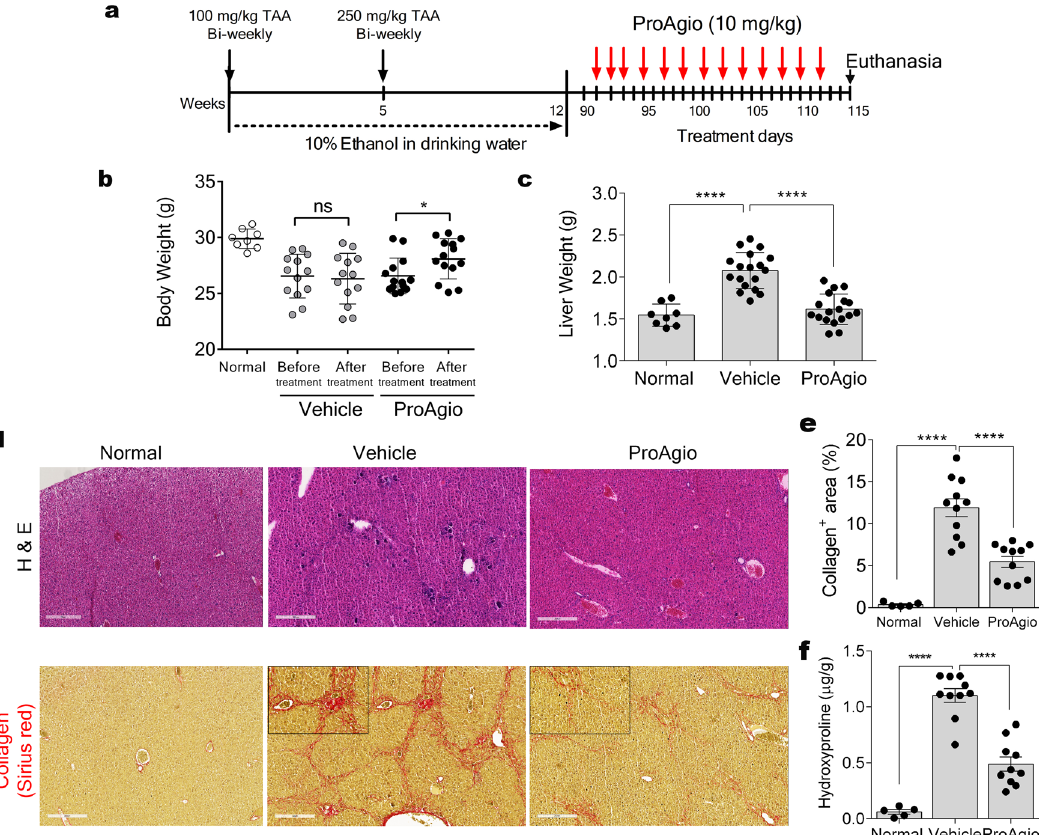
Fig. 2 ProAgio reverses liver fi brosis. a Schematic illustration of the schedule of TAA/alcohol liver fi brosis induction and subsequent ProAgio treatments (red arrows). b Body and c liver weight of the animals at the endpoint of experiments ( b ) or at end of fi brosis induction (before treatment, Before) or after ProAgio treatment (After) in c . d Representative images of H&E (Upper) Sirius red (Bottom) staining of sections of liver tissues from mice treated with indicated agents. Scale bars show 300 µ m. e Quantitation of collagen levels in Sirius red staining using ImageJ software. Four randomly selected tissue sections per animal and three randomly selected view fi elds in each section were quanti fi ed. The quantity of collagen levels is presented as % of the total area. f Hydroxyproline levels in liver extracts of mice treated with indicated agents. The data in e and f were quanti fi ed from measurements of 10 mice. Error bars in e and f are standard deviations of measurements of 10 mice. Normal in b – e and f are the mice without fi brosis induction and treatment. * P < 0.05; **** P < 0.0001; ns. denotes not signi fi